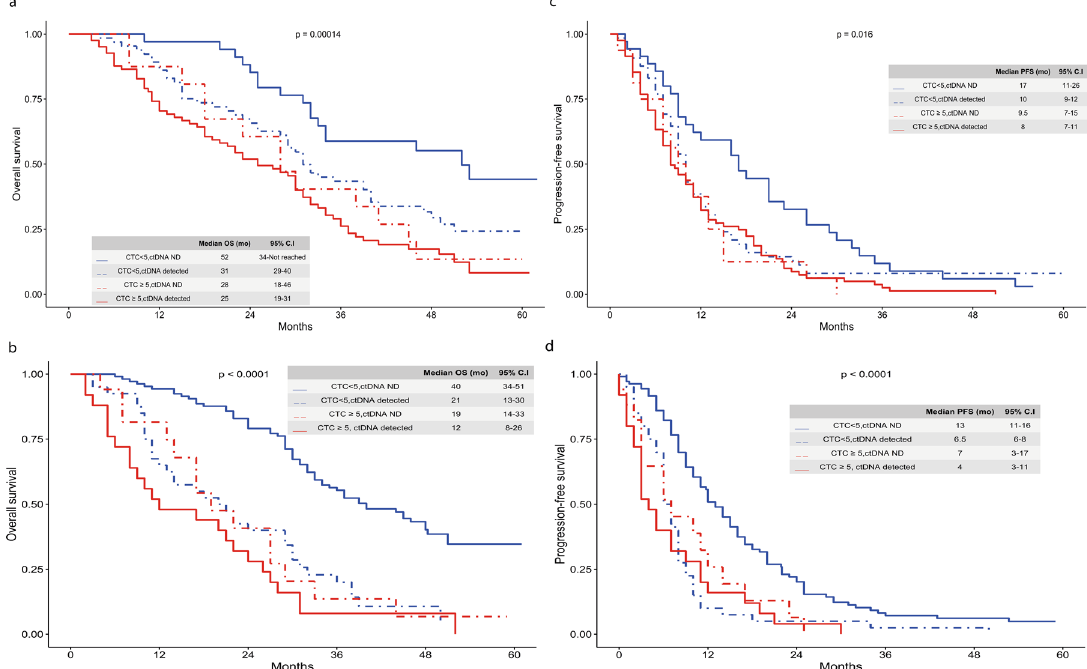
Fig. 3 Overall survival and progression-free survival according to the combination of CTC counts and ctDNA levels. OS curves by blood biomarker status at baseline ( a ) and four weeks ( b ). PFS curves by blood biomarker status at baseline ( c ) and four weeks ( d ).